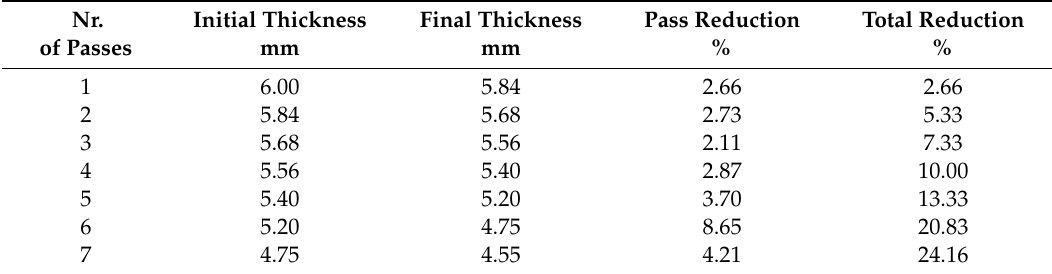
Table 4. Cold rolling deformation parameters for Cu-15% Fe 3 O 4 nanocomposite.